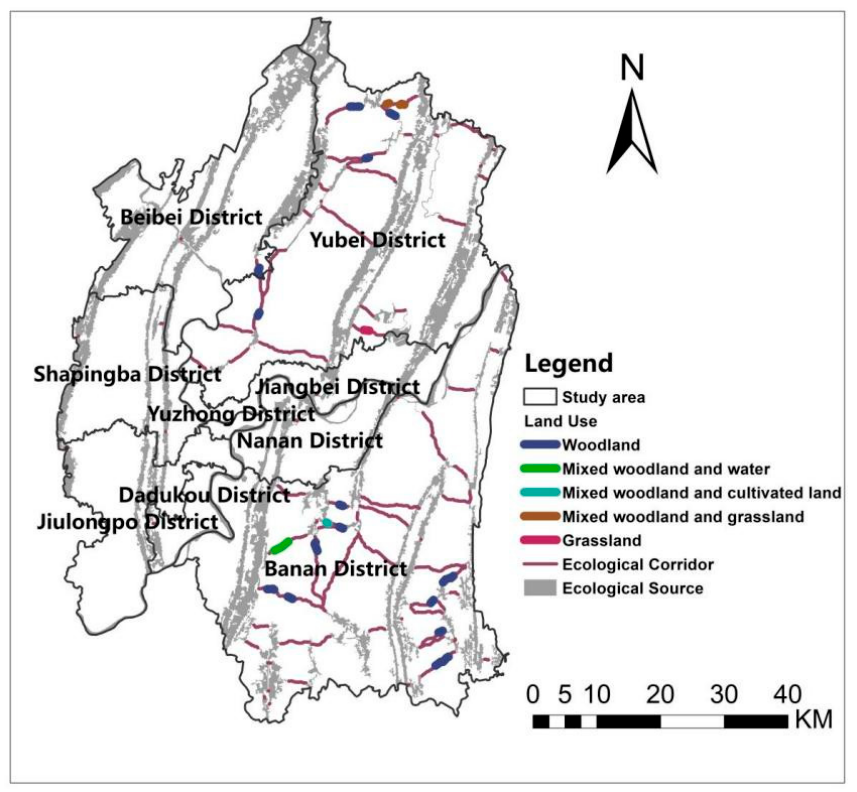
Figure 13. Types of land use at ecological “pinch points”.